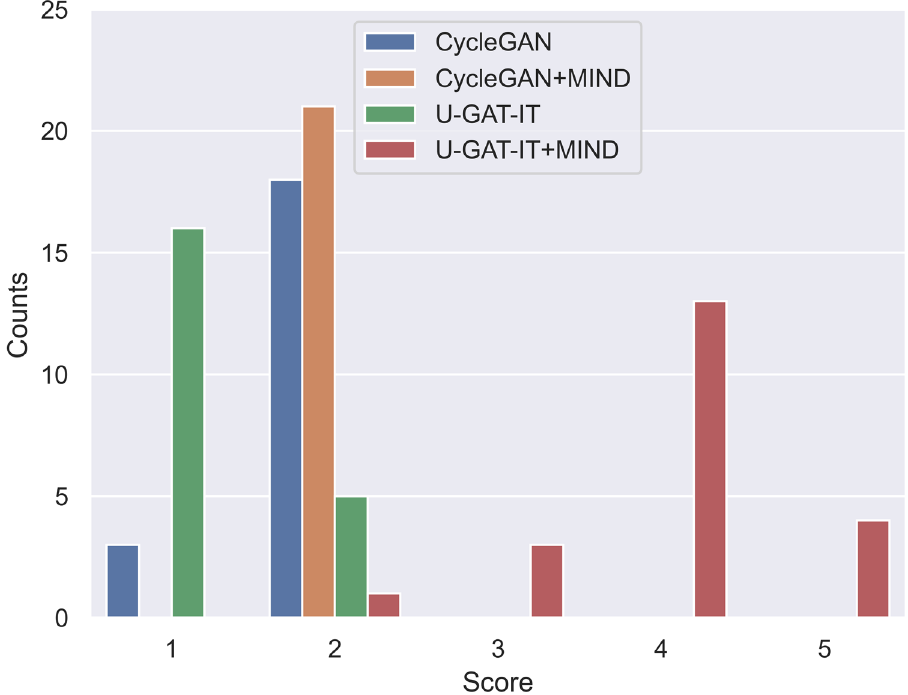
Figure 9. Distribution of evaluation scores for four groups by Dr. C.